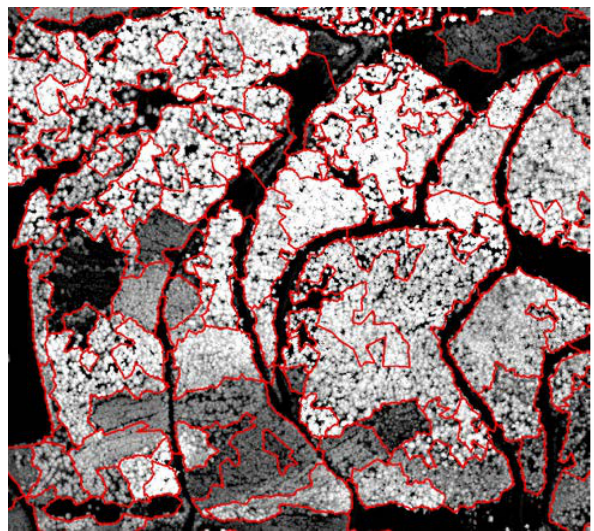
Figure 3. Segmentation result of forest stands based on nDSM.